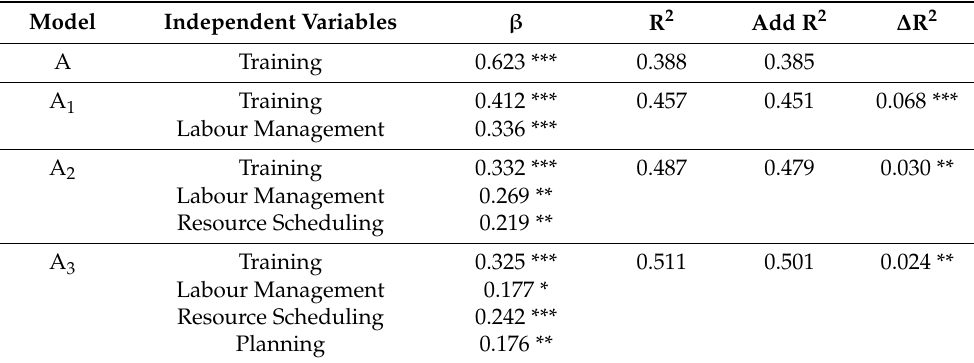
Table 2. Forward MRA models for SC. Model